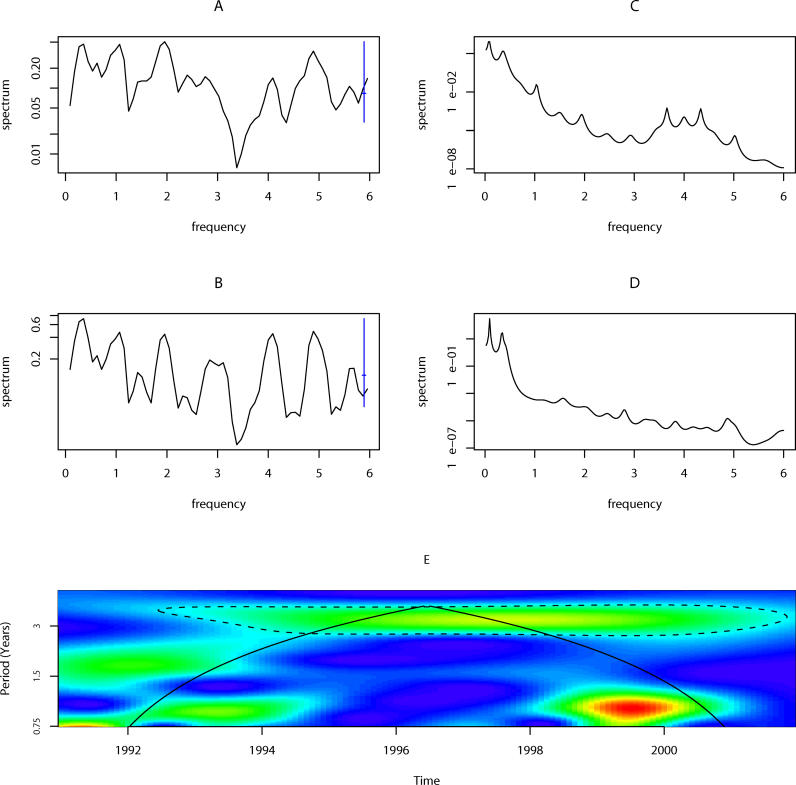
Dominant Frequencies in the Data(A and B) Smoothed periodograms for (A) the detrended series (using Daubechies discrete wavelet with filter number 5 and periodic edges) and (B) the detrended series (using Daubechies discrete wavelet with filter number 5 and symmetric edges). In the periodograms, the blue lines are the 95% point confidence intervals [19].(C and D) Maximum entropy spectral density for (C) the de-noised series (with smoothing splines) and (D) the de-noised series (with singular spectrum analysis). For the periodograms and the maximum entropy spectral density, frequencies are in cycles per year.(E) Wavelet power spectrum. The solid line is the cone of influence indicating the region of time and frequency where the results are not influenced by the edges of the data and are therefore reliable. The dashed line corresponds to the 95% confidence interval for white noise based on the variance of the square-root-transformed incidence series. The intervals were obtained using a chi-squared distributed statistic with one degree of freedom (see [22] for details). The Morlet wavelet was used [18,21,22].In all analyses, the cases are square-root-transformed. Maximum entropy spectral densities were computed using the software described in [20]. For the maximum entropy spectral density an autoregressive process of order p = 40 was used, i.e., AR(40).